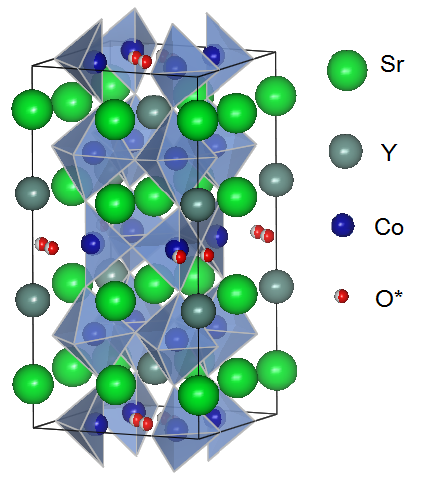
Figure 2 . Crystal structure of Sr occupancy. The octahedra and tetrahedra correspond to oxygen networks. The structure is brownmillerite-like, and the octahedra and tetrahedra are alternately stacked along the c axis. Sr and Y are ordered along the ab plane, and are stacked along the c axis with a periodicity like